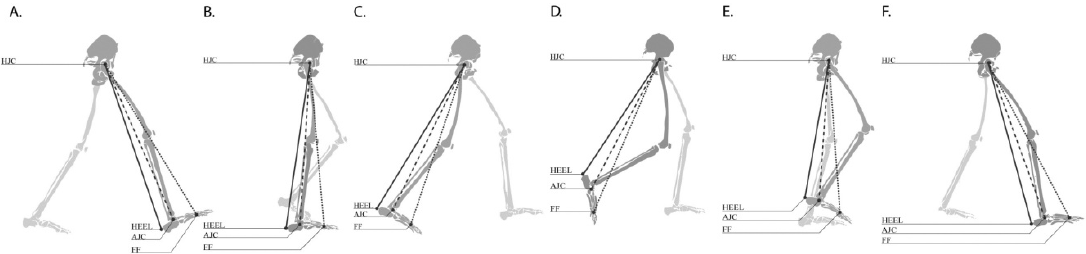
Figure 1. DLLs during the gait cycle phases measured from HJC to the HEEL, to the AJC, and to the FF. ( A ) Initial contact, ( B ) mid stance, ( C ) pre-swing, ( D ) initial swing, ( E ) mid swing, ( F ) terminal swing.